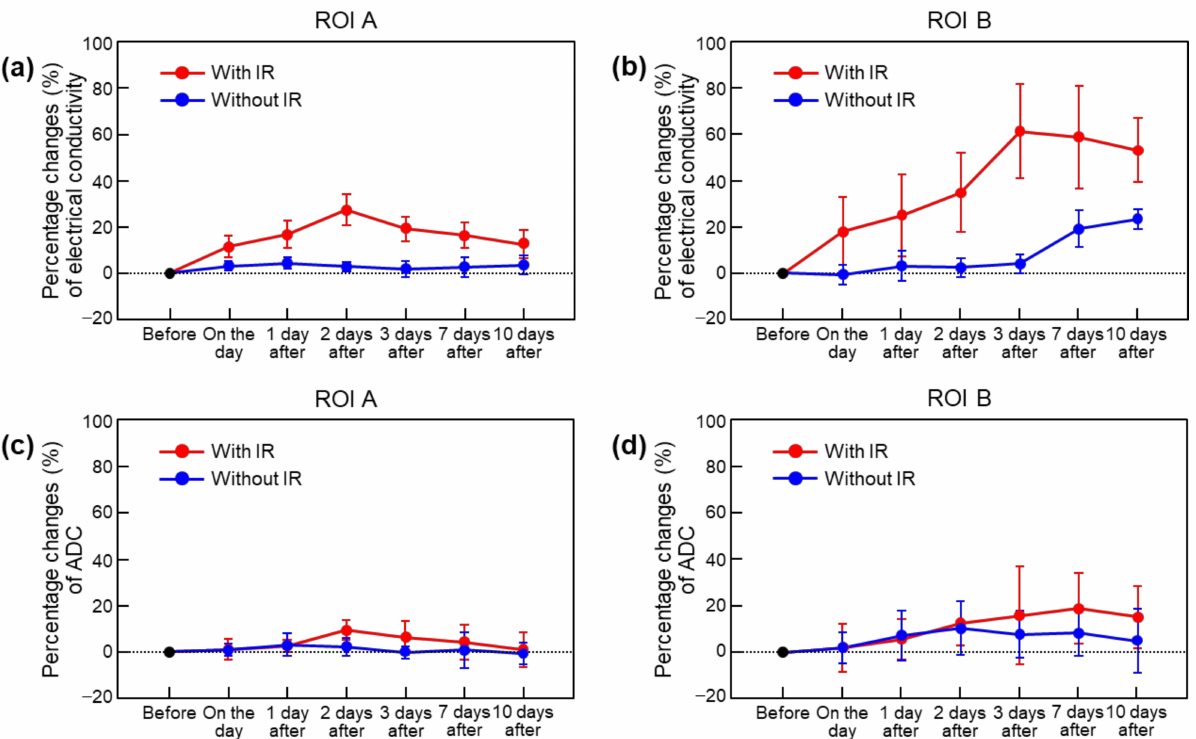
Figure 5. Comparison of percentage changes in absolute conductivity and apparent diffusion coeffi- cient (ADC) with and without irradiation. Percentage changes in electrical conductivity ( a , b ) and ADC ( c , d ) in ROIs were calculated following irradiation based on values before